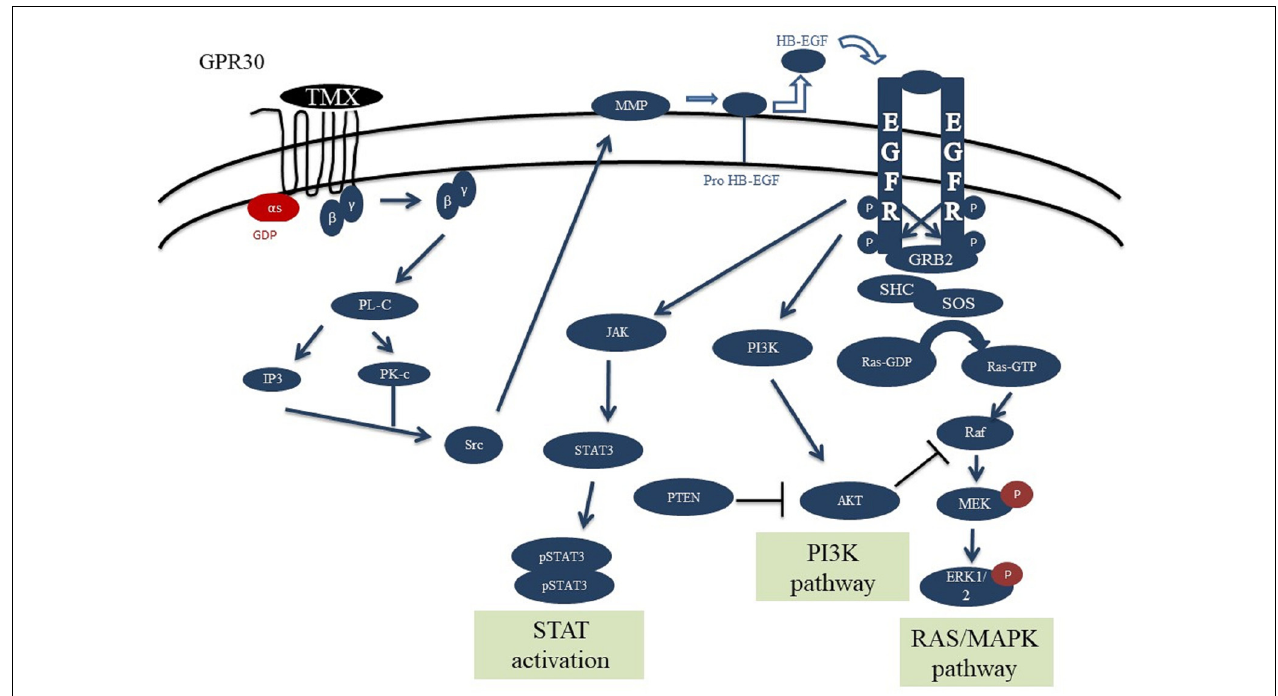
FIGURE 1 | Schematic overview of the GPR30/EGFR/PI3K/STAT signaling axis. This network consists of the interaction between GPR30/PI3K/MAPK/STAT pathways. Initial stimulation by tamoxifen causes activation of GPR30 receptors and activation of PLC by releasing the G βγ subunit which can trigger ERK activation. Also, src can activate MMPs which can convert HB-EGF to EGF. EGF can bind and activate EGFR, causing receptor dimerization and cross-phosphorylation of tyrosine residues in the intracellular domains. The activated EGFR axis can phosphorylate ERK and through that regulates various cell processes. PI3K and JAK can be recruited to cell membrane by interaction with EGFR phosphotyrosine docking sites. PI3K subsequently causes AKT activation and regulates cell growth and survival. Activation of STAT dimers by JAK play a key role in controlling cell growth and survival. Since JAK-STAT signaling can allow the transcription of genes involved in cell division, one potential effect of excessive JAK-STAT signaling is cancer